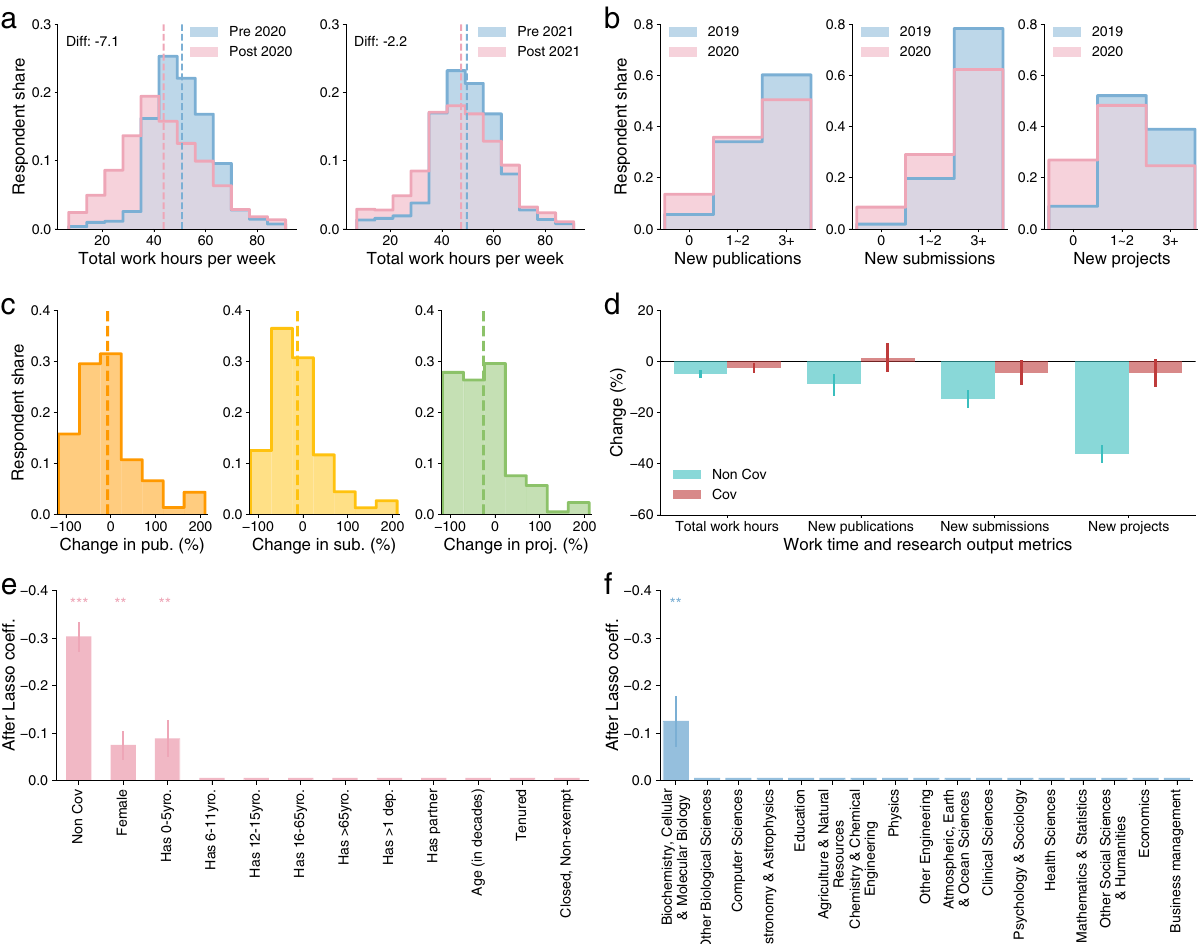
Fig. 1 Gradual recovery of total work time and substantially fewer new research projects. a The distributions of total work hours per week for the pre- and post-periods. The left and right panels correspond to the surveys in April 2020 and January 2021, respectively. Vertical dashed lines mark the means, and the difference in means is shown. b The distributions of new publications, new submissions, and new projects for 2019 and 2020. Reported values are categorized into three bins. c The distributions of the changes in new publications, new submissions, and new projects in 2020 relatively to 2019. Changes over 200% are set as 200%. Vertical dashed lines mark the means. d The average change in work time and output metrics, unpacked by whether scientists have worked on COVID-19-related topics in 2020. Error bars indicate 95% con fi dence intervals. e Regression analysis of the change in new research projects. The Lasso regression selects professional and demographic features most predictive of the declines in new projects after controlling for research fi elds. The regression also includes a COVID-19 dummy variable capturing whether the respondent reported engaging with COVID-19-related research in 2020. f The Lasso regression selects fi eld features most predictive of the declines in new projects after controlling for demographic factors and the non-COVID-19 dummy. Error bars indicate standard errors, and stars indicate signi fi cant levels: * p < 0.1, ** p < 0.05, *** p <